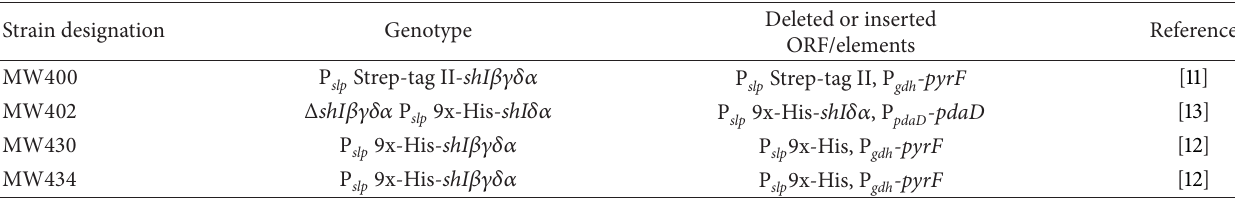
Figure 2: Genetic strategy for overexpression of SHI. MW400 is used as the example. The knock in cassette contains upstream flanking region (UFR) and downstream flanking region (DFR) homologous to PF0890 and PF0891, respectively. This cassette also contains a selectable , the promoter for the S-layer protein (P ) to drive expression of the SHI genes, and a Strep-tag II at the marker pyrF with the promoter P gdh slp N-terminus of PF0891. By homologous recombination, this cassette was inserted into the SHI locus in P. furiosus COM1. Table 2: Strains for SHI